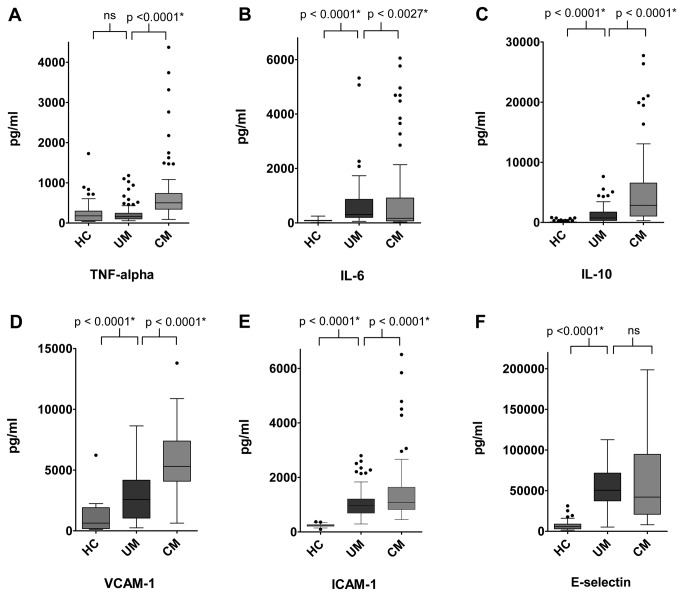
Graphs showing medians with ranges of A) TNF-α B) IL-6 C) IL-10 D) VCAM-1 E)ICAM-1 and F) E-selectin levels in healthy controls, uncomplicated and complicated cases as measured by ELISA (Mann-Whitney).ns=not-significant, p<0.05 after Bonferroni correction for multiple comparisons (6 pair wise comparisons).Healthy controls N=100,Uncomplicated malaria N=100, Complicated malaria N=82.